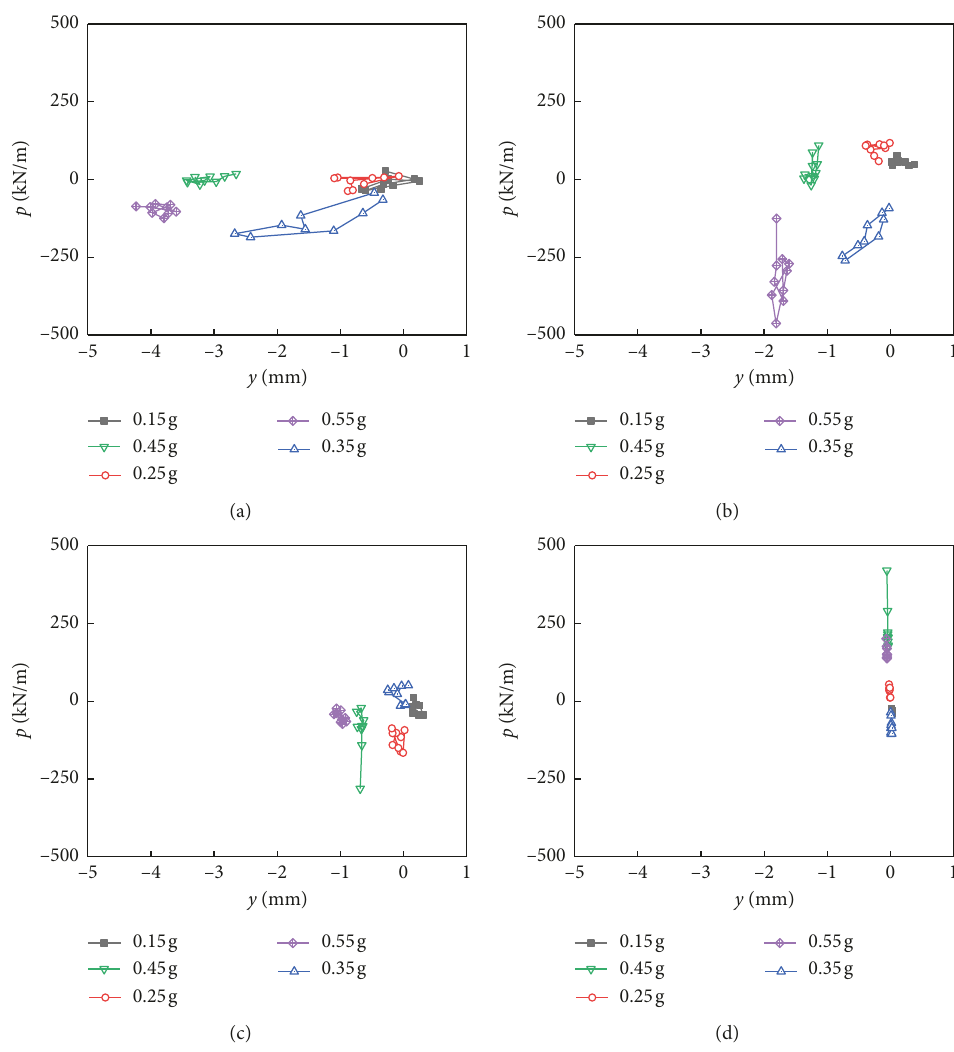
Figure 20: The p-y hysteresis curves of the pile at different depths. (a) 23.5cm. (b) 63.5 cm. (c) 104.0cm. (d)